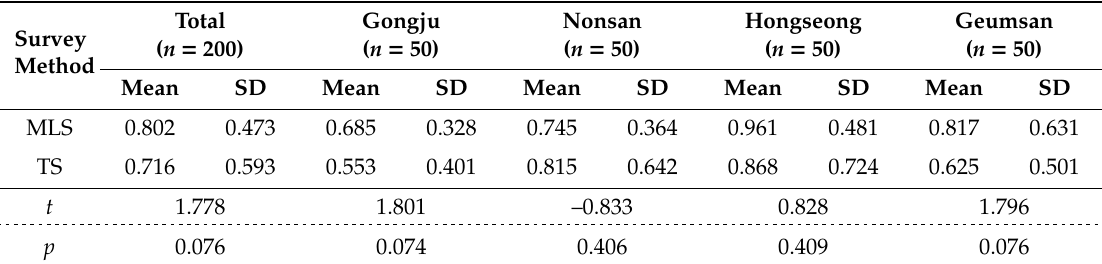
Table 6. RMSEs of the Mobile Laser Scanner (MLS) or Total Station (TS survey) to the Global Navigation Satellite System (GNSS) survey for 50 corresponding points for each road